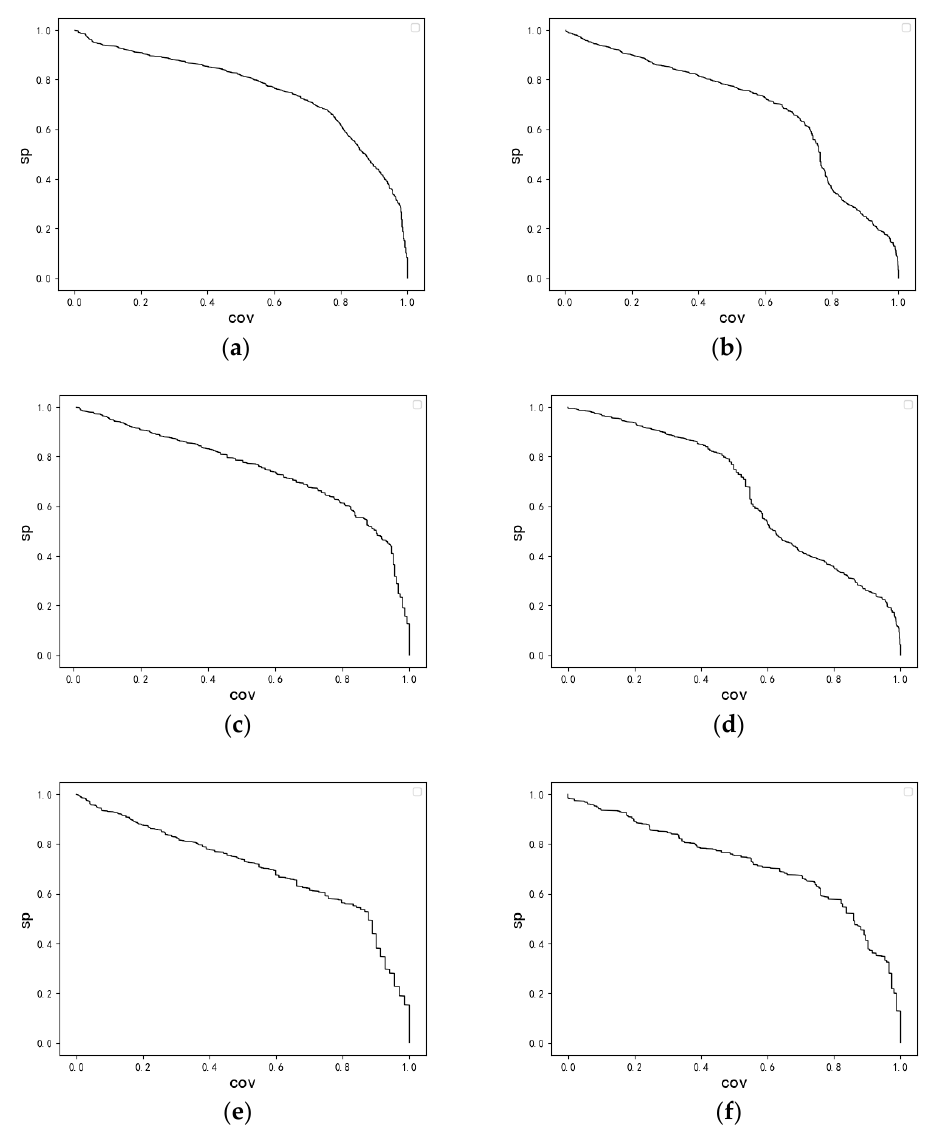
Figure 6. The curve of cov-sp values for the upper bound. ( a ) Cluster 0, 1st dimension ( b ) Cluster 0, 2nd dimension ( c ) Cluster 1, 1st dimension ( d ) Cluster 1, 2nd dimension ( e ) Cluster 2, 1st dimension ( f ) Cluster 2, 2nd dimension.